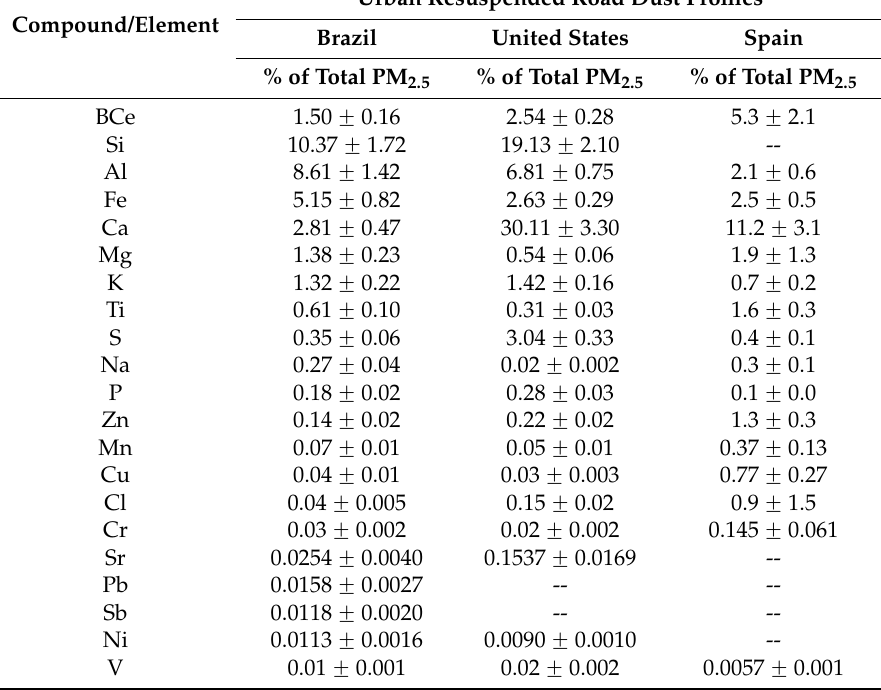
Table 4. Profile of resuspended road dust from the three outside-tunnel sites evaluated in Brazil, together with comparable profiles for cities in Texas and for the city of Seville,